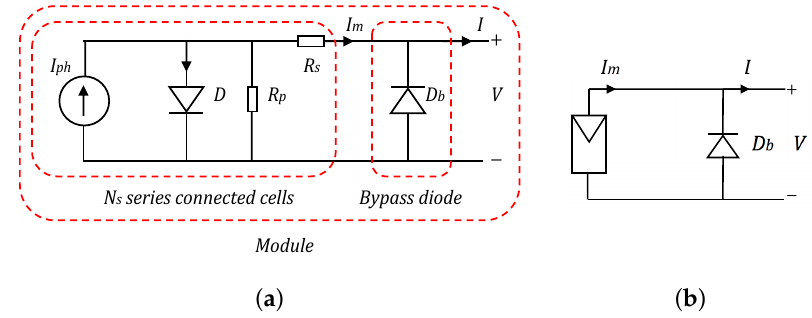
Figure 1. Electrical model of a PV submodule by using ( a ) single diode model and ( b ) a simplified representation of the single diode